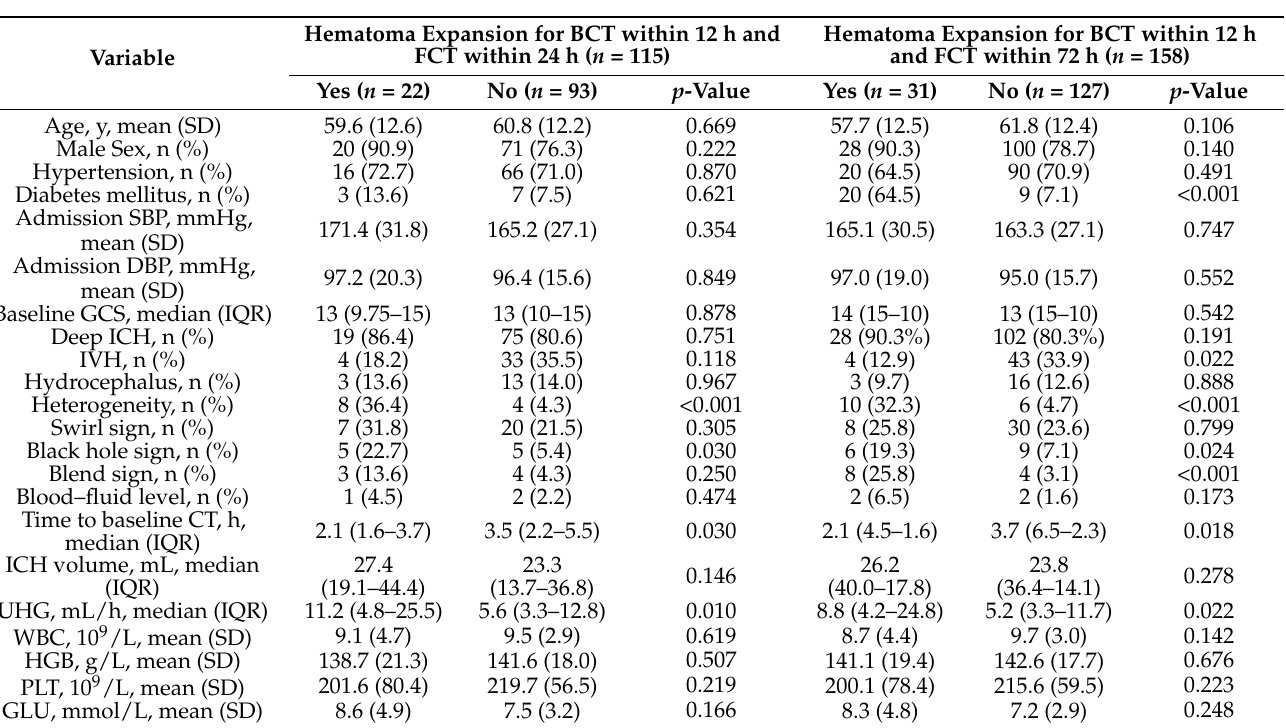
Table 5. Comparison of baseline clinical and radiological characteristics of individuals with and without hematoma expansion for time to baseline CT within 12